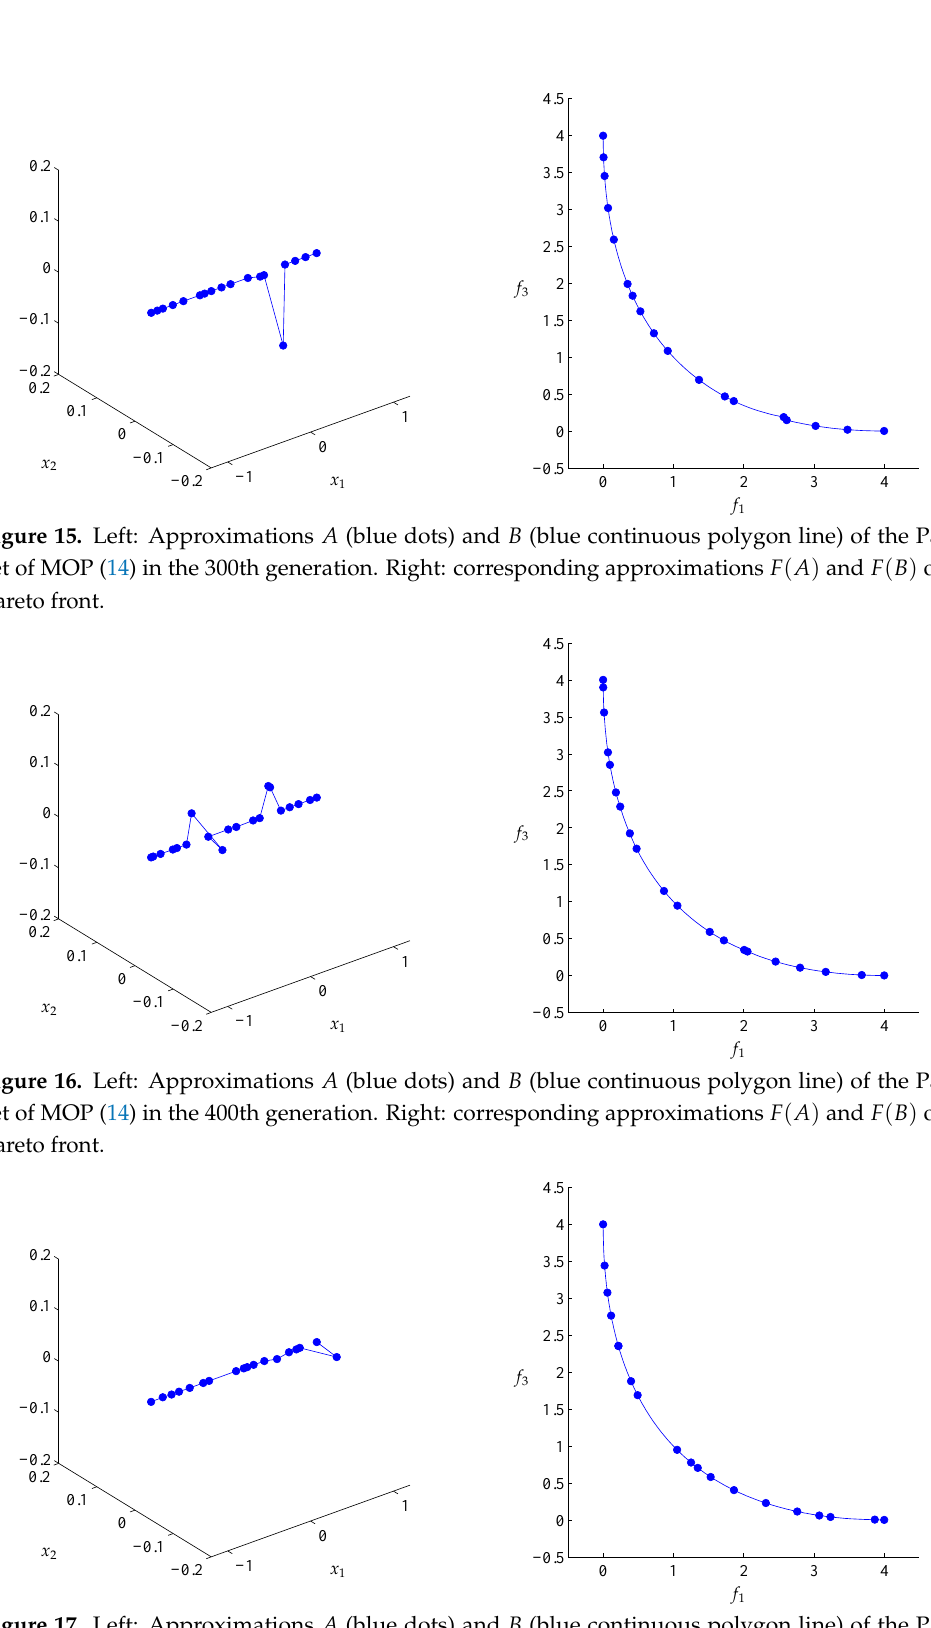
Figure 17. Left: Approximations A (blue dots) and B (blue continuous polygon line) of the Pareto set of MOP (14) in the 500th generation. Right: corresponding approximations F ( A ) and F ( B ) of the Pareto